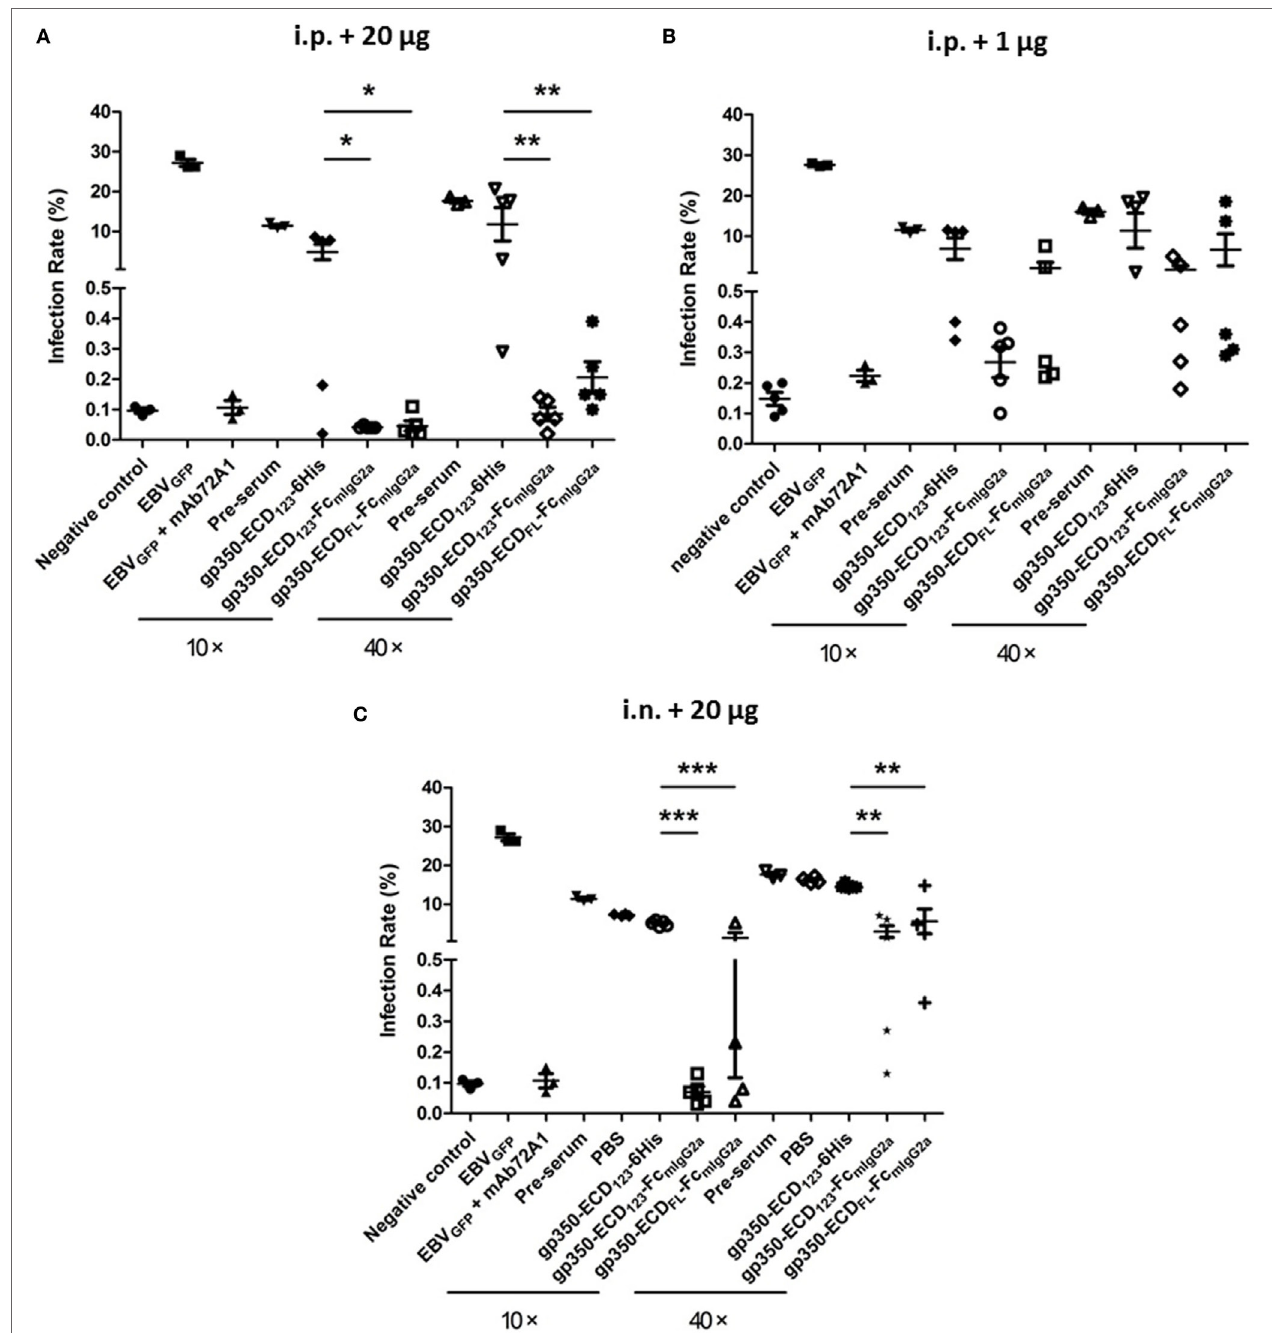
FigUre 5 | Neutralization of EBV GFP infection by sera collected at week 5 post-immunization. Recombinant EBV GFP was preincubated with 10 × or 40 × dilutions of sera from mice immunized with the indicated antigens. Virus was added to Akata cells, and GFP fluorescence was recorded as a measure of infection. The reported infection rates consist in the percentages of GFP positive cells as analyzed by flow cytometry. Virus infection was blocked by diluted sera developed through immunization. (a) Mice immunized i.p. with 1 µg antigen. (B) Mice immunized i.p. with 20 µg antigen. (c) Mice immunized i.n. with 20 µg antigen. Significance (* p ≤ 0.05, ** p < 0.01, and *** p < 0.001) between Fc fusion proteins versus monomer gp350 proteins is